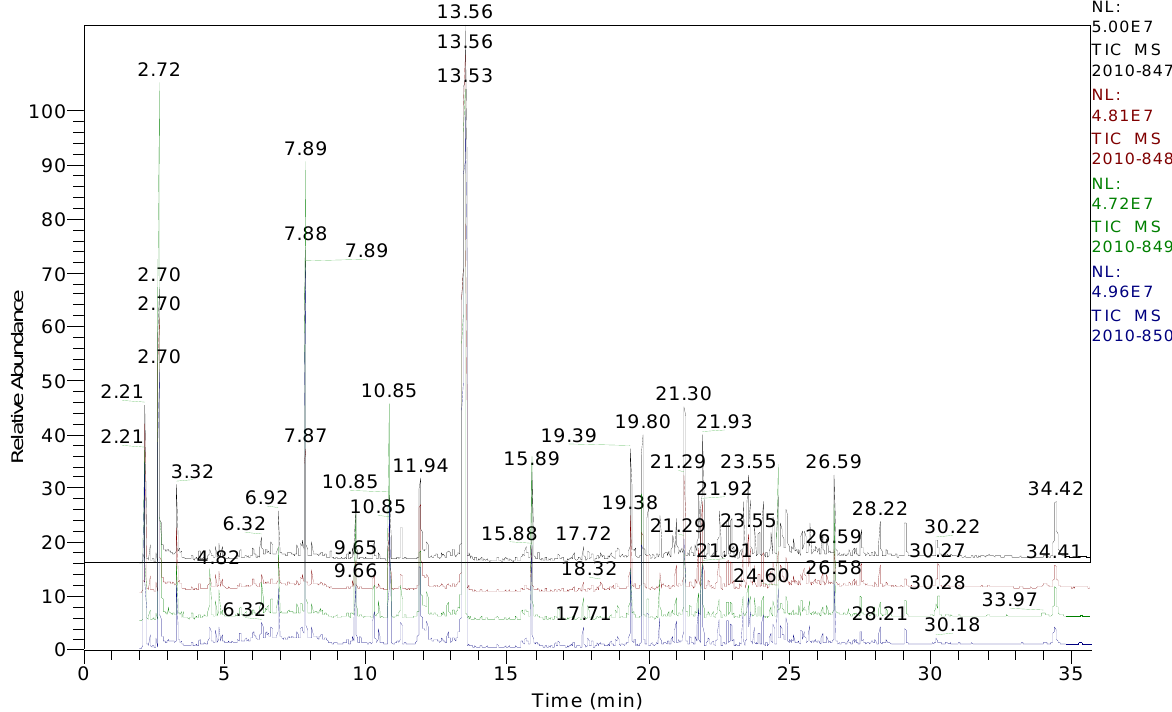
Figure 1. GC/MS total ion current chromatogram of the essential oils of the four samples. RT: 0.00 - 35.66